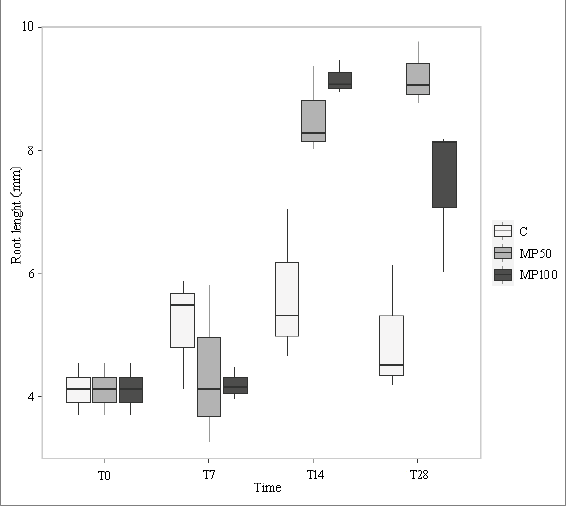
Figure 6. Root length (mm) of L. minuta , measured in control (C) and microplastic treatments (MP50, MP100) at different exposure times (T0, T7, T14, T28).